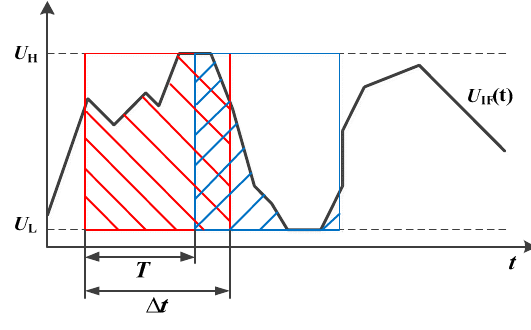
Figure 10. The curve of intermittent failure.